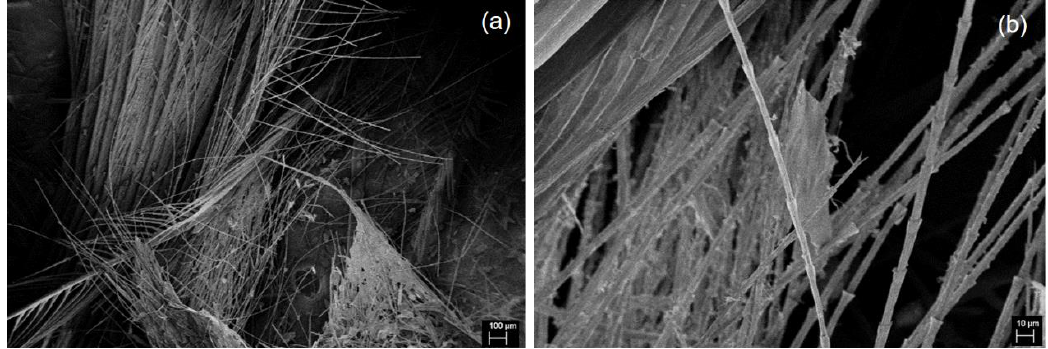
Figure 1. SEM images of WCF at ( a ) 100× and ( b ) 1000× magnification.